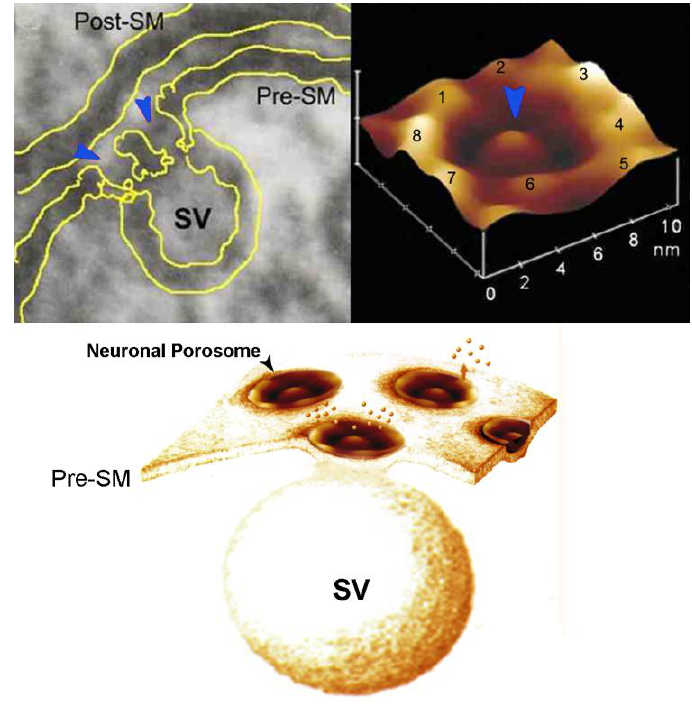
FIGURE 1. The neuronal porosome complex at the presynaptic membrane, where synaptic vesicles transiently dock and fuse to release neurotransmitters. The top left panel shows an electron micrograph with a 40-nm diameter synaptic vesicle fused at the base of a 12-nm cup-shaped neuronal porosome with a central plug. The top right panel depicts an atomic force micrograph of a neuronal porosome with a central plug (indicated by arrowhead). The bottom panel is a schematic illustration of native neuronal porosome complexes at the presynaptic membrane and a transiently fused synaptic vesicle at its base during neurotransmitter release. (Courtesy of Prof. Bhanu P.